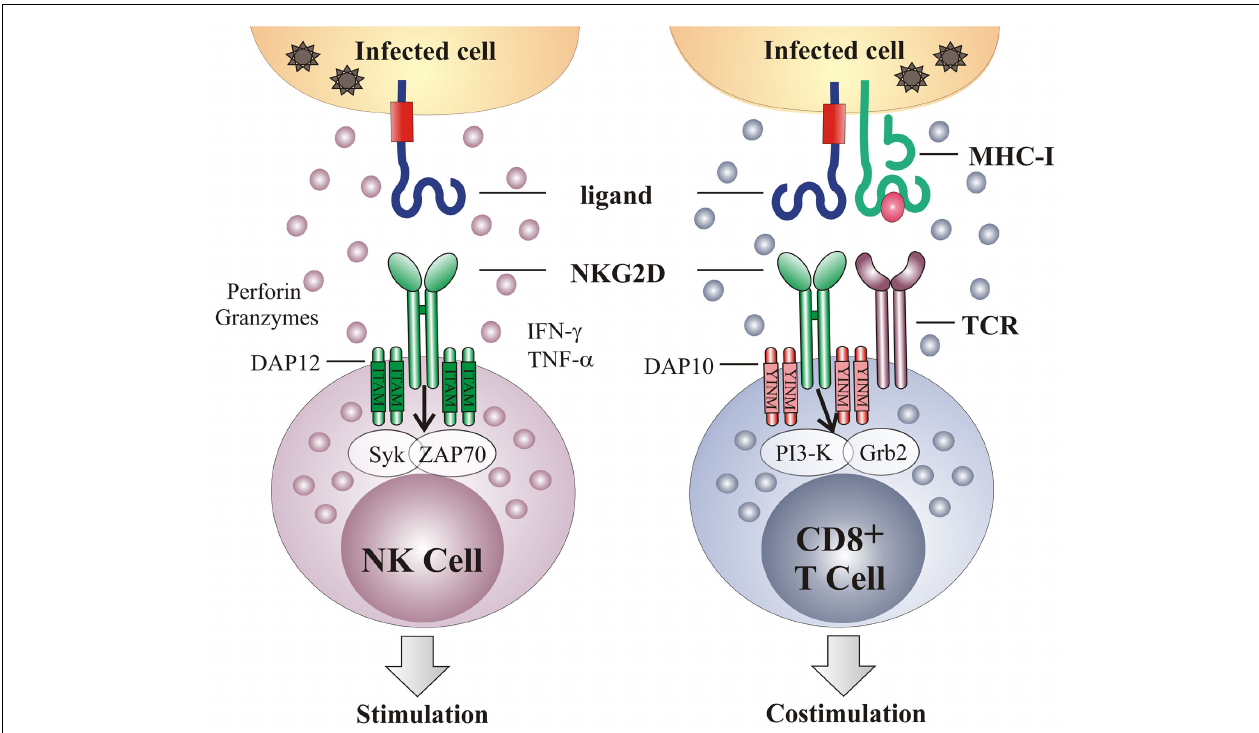
sufficient to trigger NK cell-mediated cytotoxicity and cytokine production. In contrast, NKG2D acts as a co-stimulatory receptor on CD8T cells, requiring TCR-mediated signaling for their full activation. Grb2, growth factor receptor-bound protein 2; IFN- γ , interferon γ ; ITAM, immunoreceptor tyrosine-based activating motif; PI3K, phosphoinositide 3-kinase; Syk, spleen tyrosine kinase;TCR,T cell receptor;TNF- α , tumor necrosis factor α ; Zap70, zeta-chain associated protein kinase